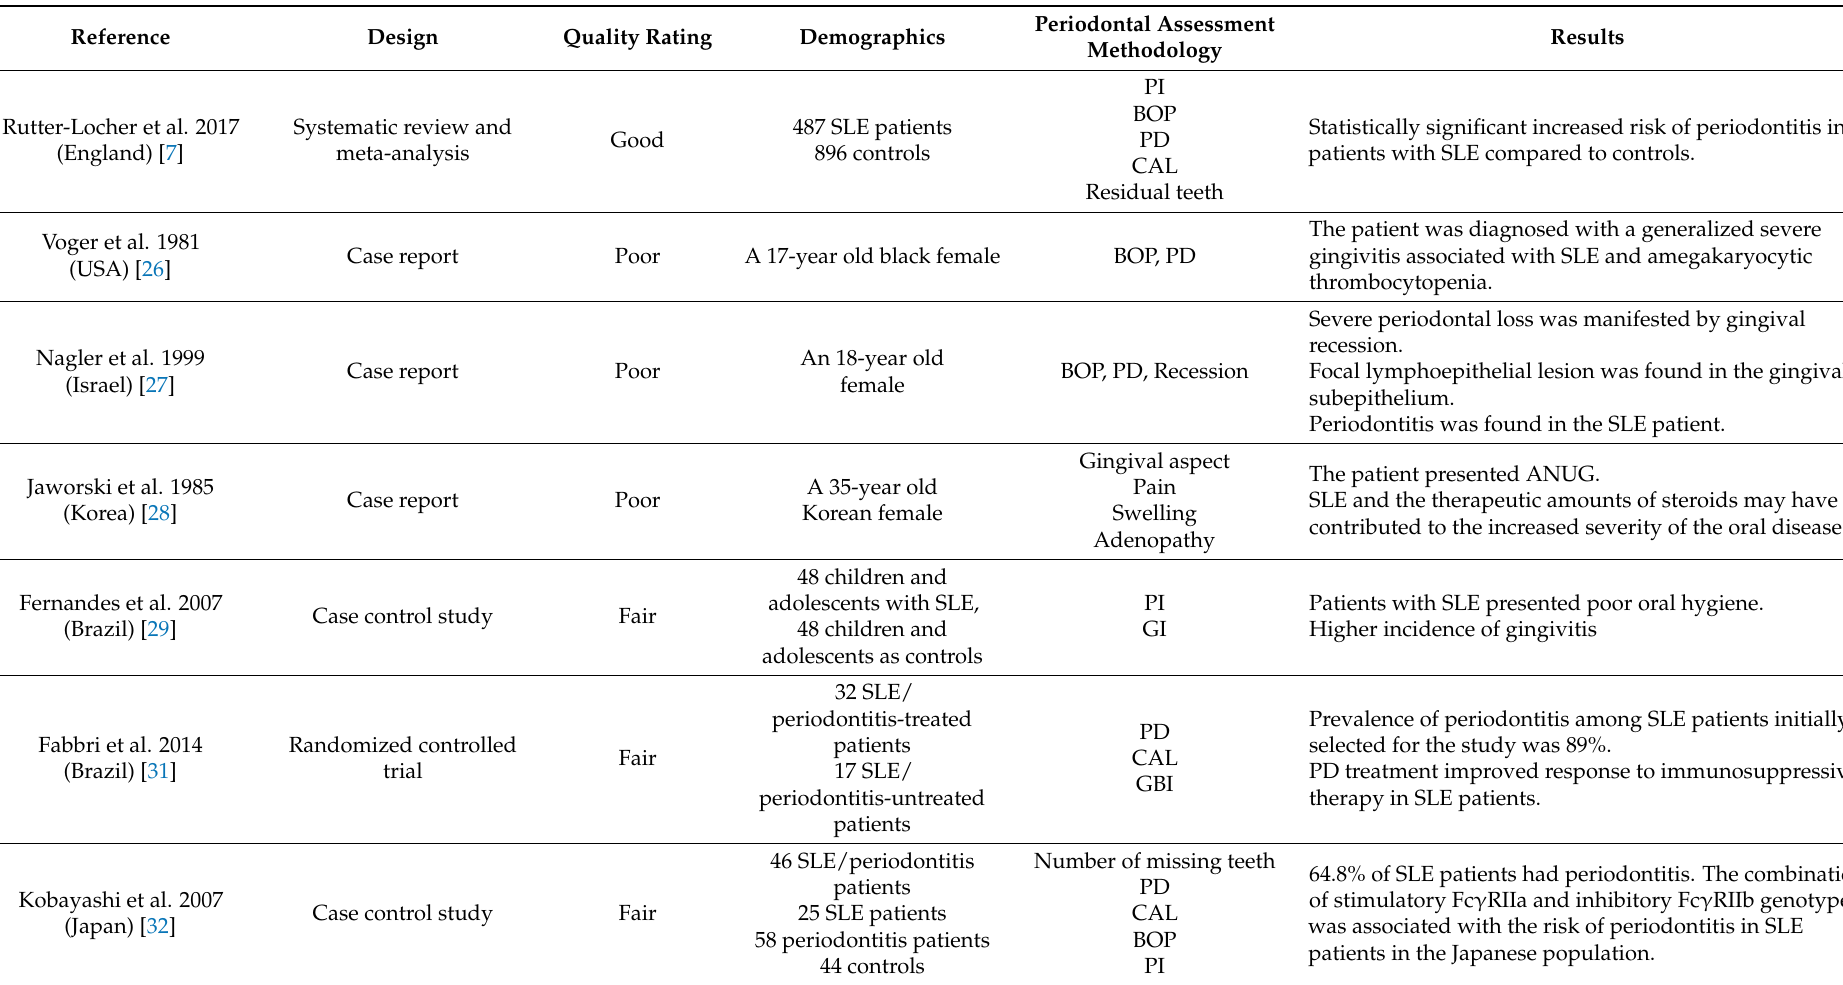
Table 1. Epidemiologic observational studies investigating the association between PD and